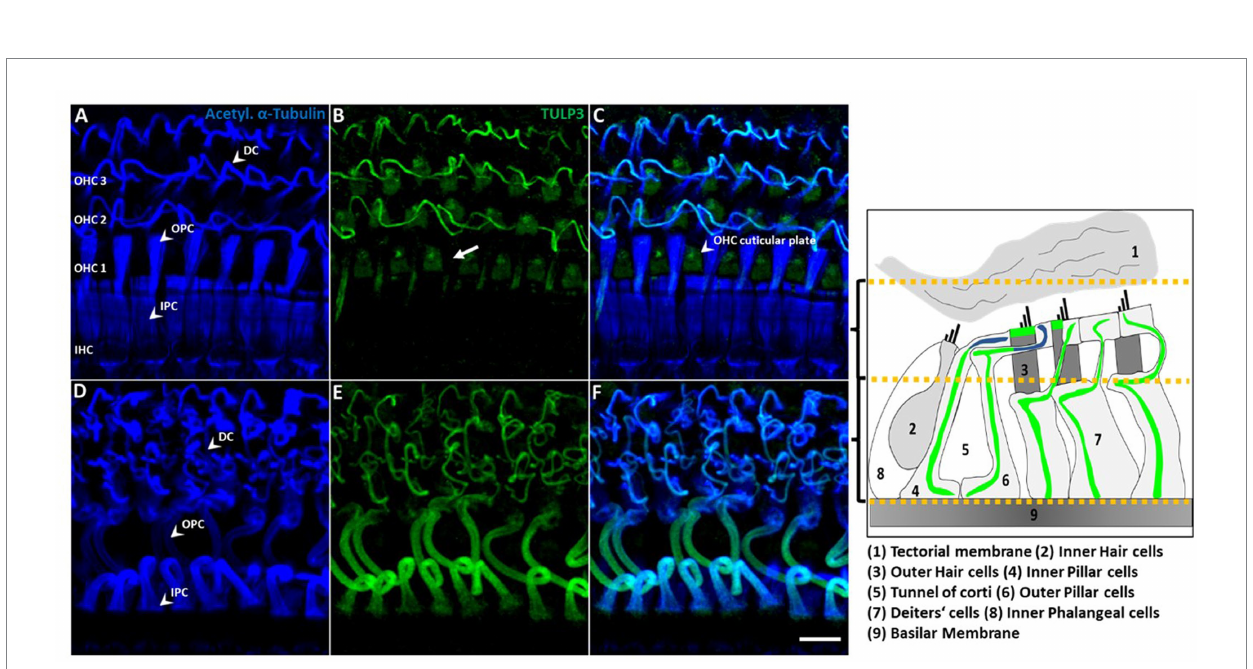
FIGURE 5 TULP3 immunoreactivity is localized to supporting cell microtubule bundles and the OHC cuticular plate. (A – F) P30 whole-mount immunohistochemical staining of TULP3 (green) with acetylated α -tubulin (blue) in the mouse organ of corti. TULP3 co-localizes with acetylated α -tubulin in Deiters‘cells (DC), outer (OPC) and inner pillar cells (IPC) but is absent in pillar heads ( B , arrow). Additionally, TULP3 immunoreactivity is present in the OHC cuticular plate (arrowhead, C ). Scale bar 10 μ m. Right cartoon: Schematic simplification of the detected TULP3 immunosignal within the apical and basal half of the organ of